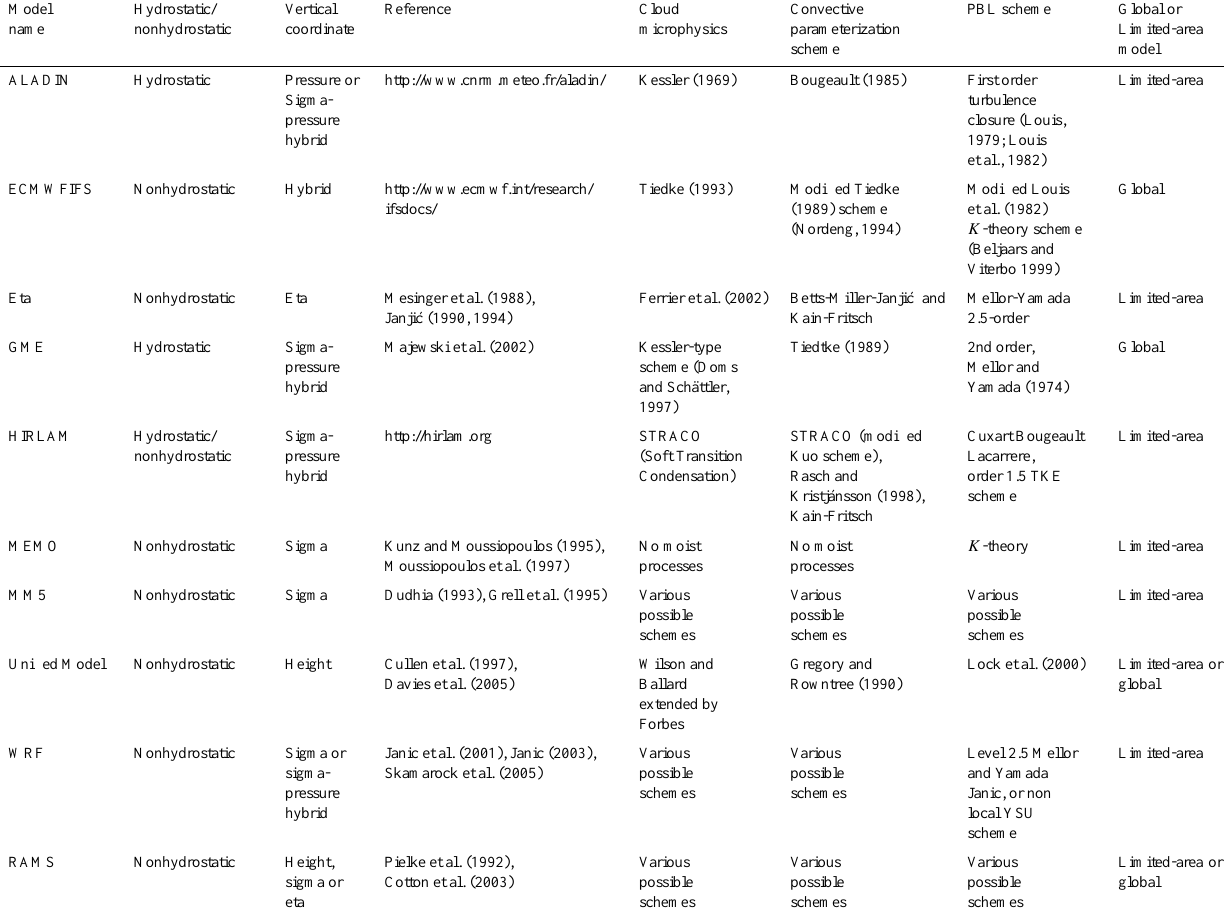
Table 2. Selected main characteristics of the numerical weather prediction models